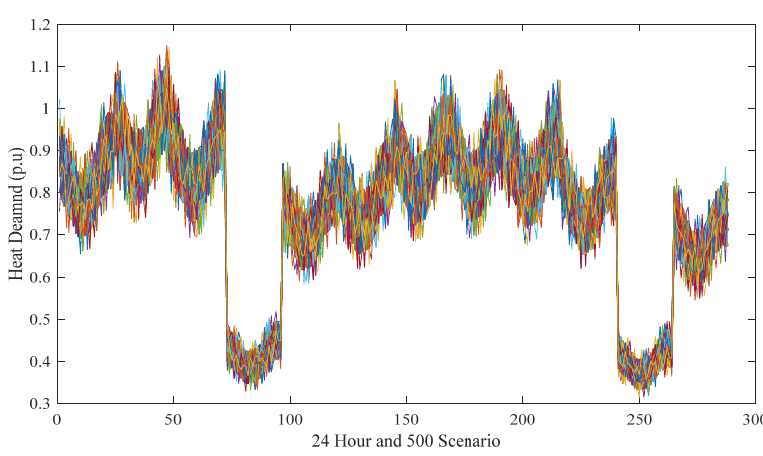
Figure 11. Heat demand prediction using LSTM.